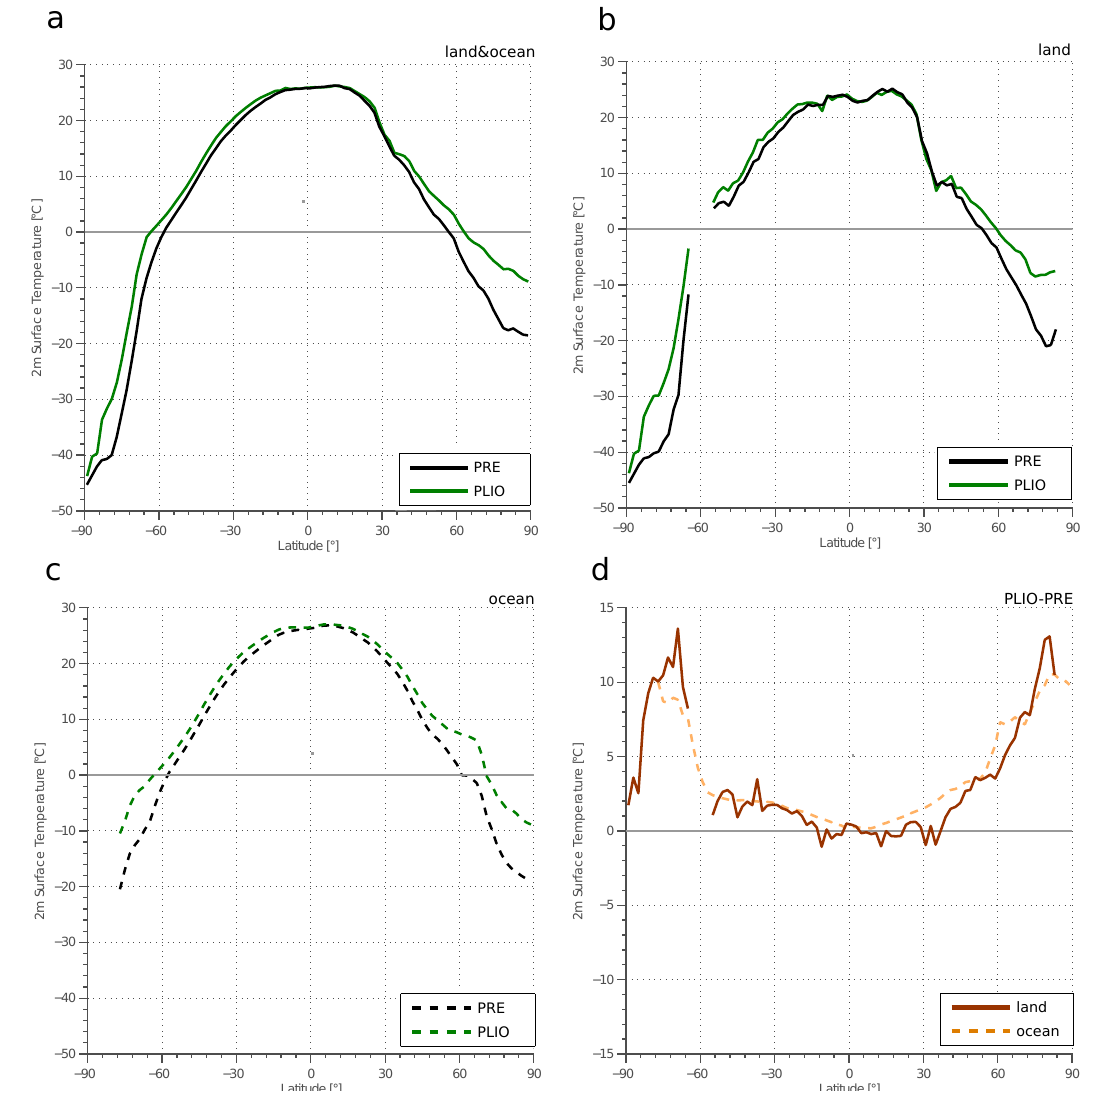
Fig. 6. Latitudinally averaged surface temperatures ( ◦ C) for (a) land and ocean, (b) land only, and (c) ocean only grid cells for pre-industrial (black) and mid-Pliocene (green) experiments. (d) Differences in zonal mean surface temperatures ( ◦ C) between mid-Pliocene and pre- industrial scenarios for land (solid red) and ocean (dashed orange). Table 2. Boreal summer (JJA), winter (DJF) and annual (ANN) global climatological means of net upward energy flux for top-of-atmosphere (TOA) and surface (Wm − 2 ), surface temperature ( ◦ C) and precipitation rate (mmd − 1 ) for pre-industrial (PRE), mid-Pliocene (PLIO), and differences between scenarios (PLIO-PRE). Note that a known long-standing spurious net energy sink of ∼ 2.0Wm − 2 in the GENESIS atmospheric model (due to inexact treatment of water-vapor specific heat in the spectral dynamics) should be taken into consideration when comparing all top-of-atmosphere upward